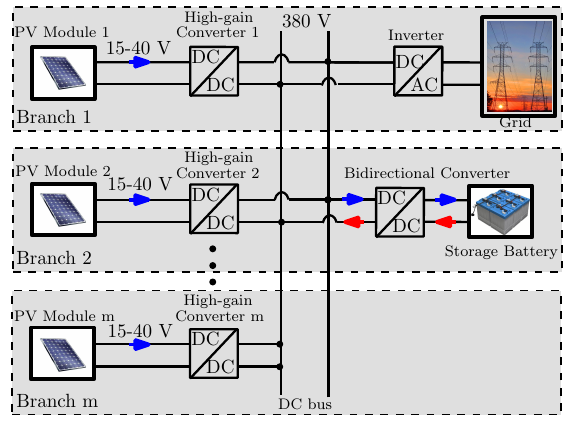
Figure 1. A model of a PV-based DC microgrid equipped with high-voltage-gain